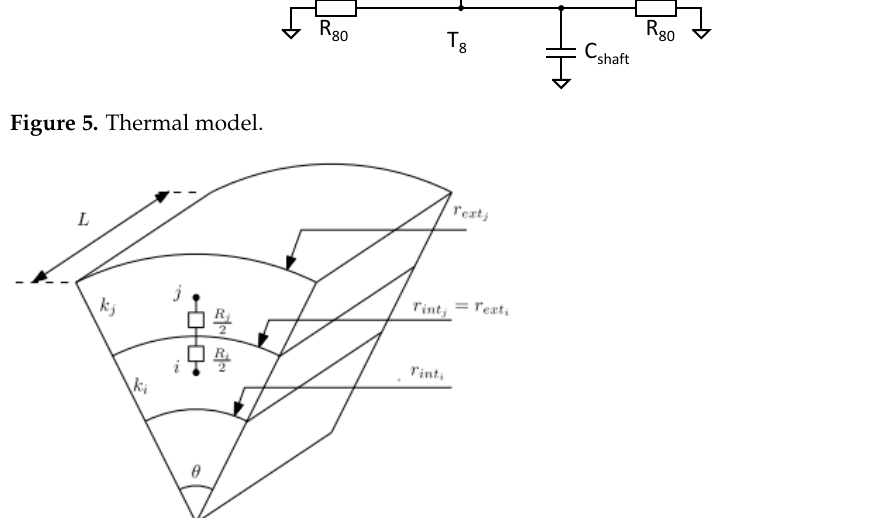
Figure 7. Thermal simulation for S3 10% duty cycle. The simulation result on S3 30% duty cycle is shown in Figure 8. The winding tem- perature only reaches 101 °C while the rotor temperature reaches 165 °C. The first one is far from the class H limit (180 °C) chosen in the design and the second one gets closer to the thermal-electromechanical limit when operating at high speed with some safety mar- gin.